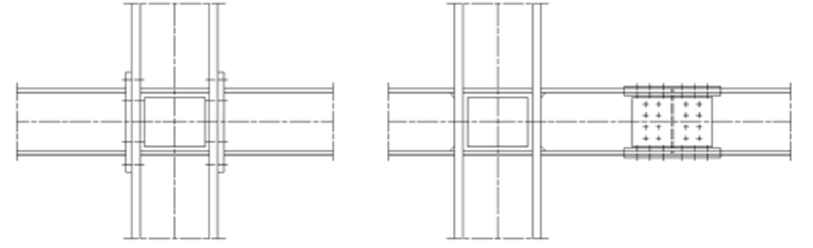
Figure 9. Connections in (predominantly) bent members. From left to right: end plates; web and flanges cover plates. Table 2. Steps of practical seismic design of bolted steel connections according to Eurocodes.